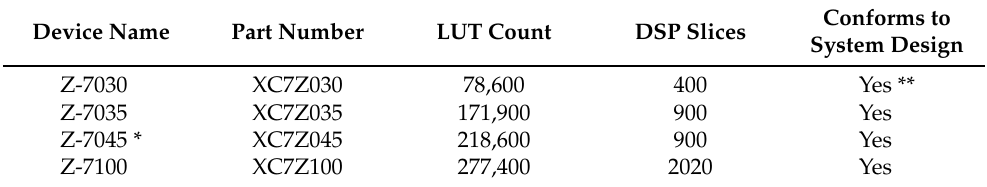
Table 2. Properties of Zynq-7000 SoC-FPGA devices that include a Kintex-7